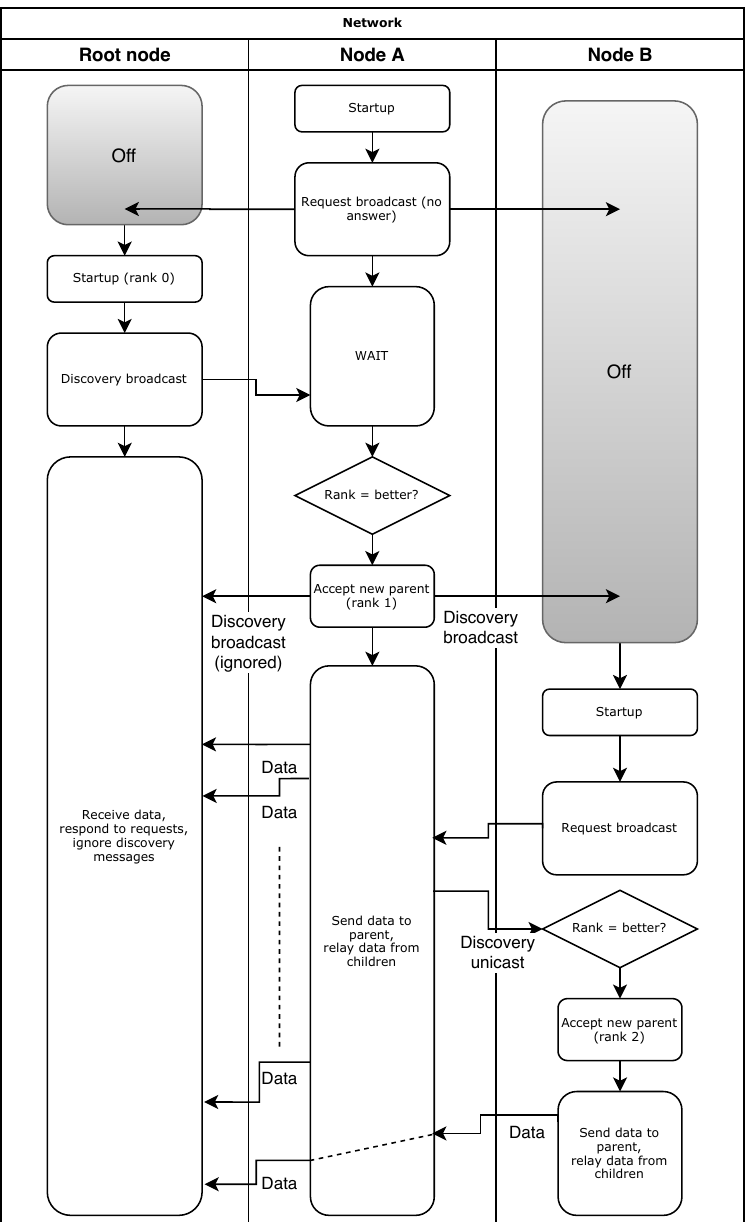
Figure 10. Message exchange in a normal operation under